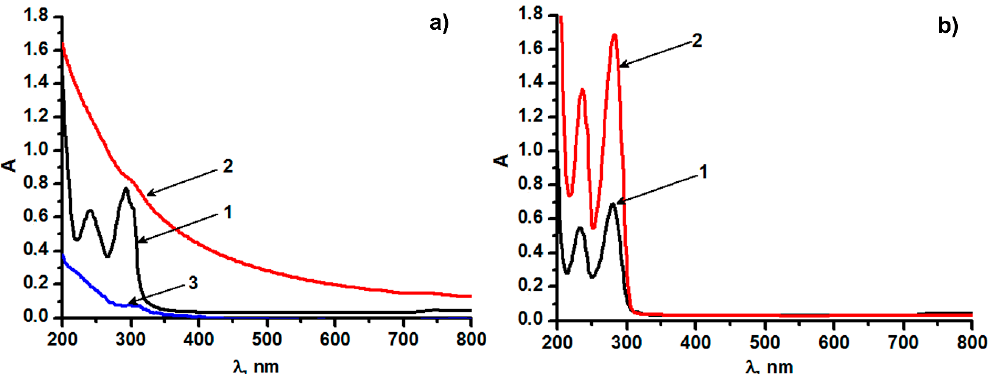
Figure 2. UV-Vis absorbance spectra in ethanol of: ( a ) 1 — Co(bpy) 3 (BF 4 ) 2 (C = 1.67×10 − 5 mol·L − 1 ), Co II @SiO 2 (C = 0.2 g·L − 1 ) on the basis of Co II (bpy) 3 obtained by different techniques: 2—Stöber, 3—w/o; ( b ) 1—bpy (C = 5×10 − 5 mol·L − 1 ), 2—supernatant after Stöber synthesis diluted 10 times.